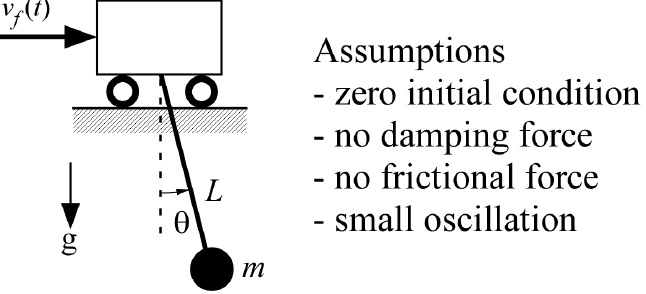
Figure 2. Pendulum